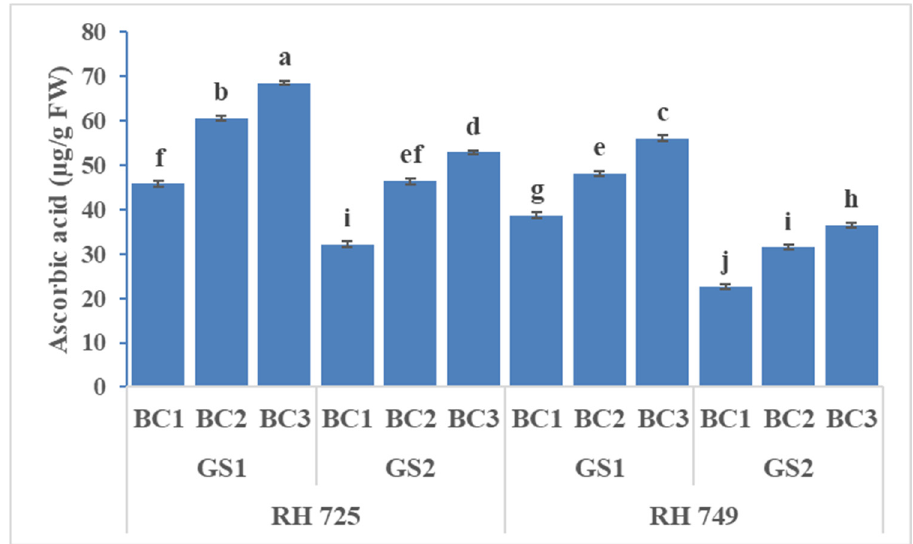
Figure 11. Comparisons of the effects of different concentrations of brassinolide sprays (BC1: control (water spray); BC2: 10 mg BRs/L water; BC3: 20 mg BRs/L water) on the ascorbic acid content (ASA) of drought-tolerant (RH 725) and drought-sensitive (RH 749) Indian mustard cultivars at the flower initiation (GS1) and 50% flowering (GS2) stages. Columns marked by different letters indicate significant differences ( p < 0.05) between treatments based on Duncan’s multiple range test. Error bars denote the standard errors of the mean.